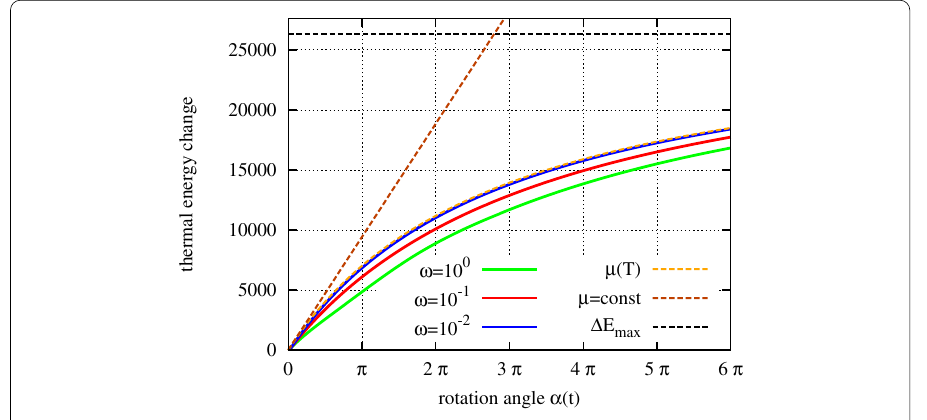
Fig. 6 Frictional heating of a rotating ring. Change of thermal energy over rotation angle at different angular frequencies